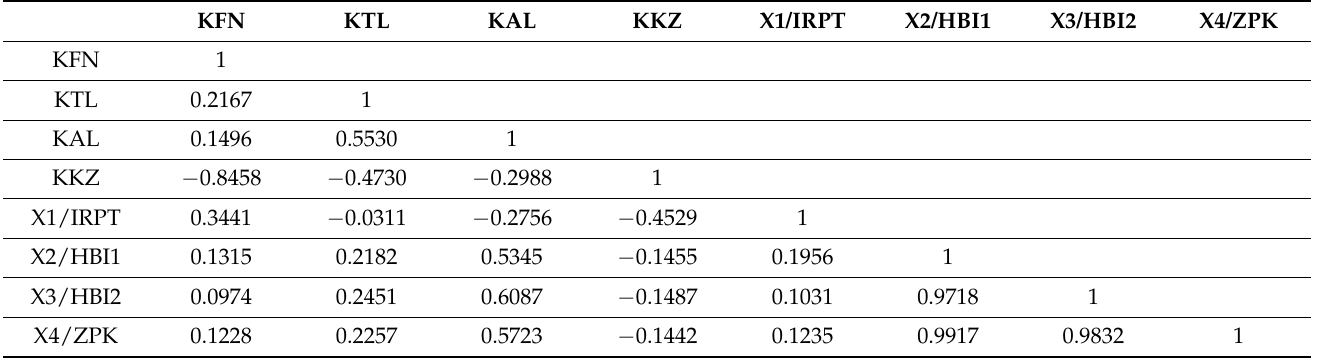
Table 5. Matrix of the pair correlation of financial sustainability indicators and digitalization